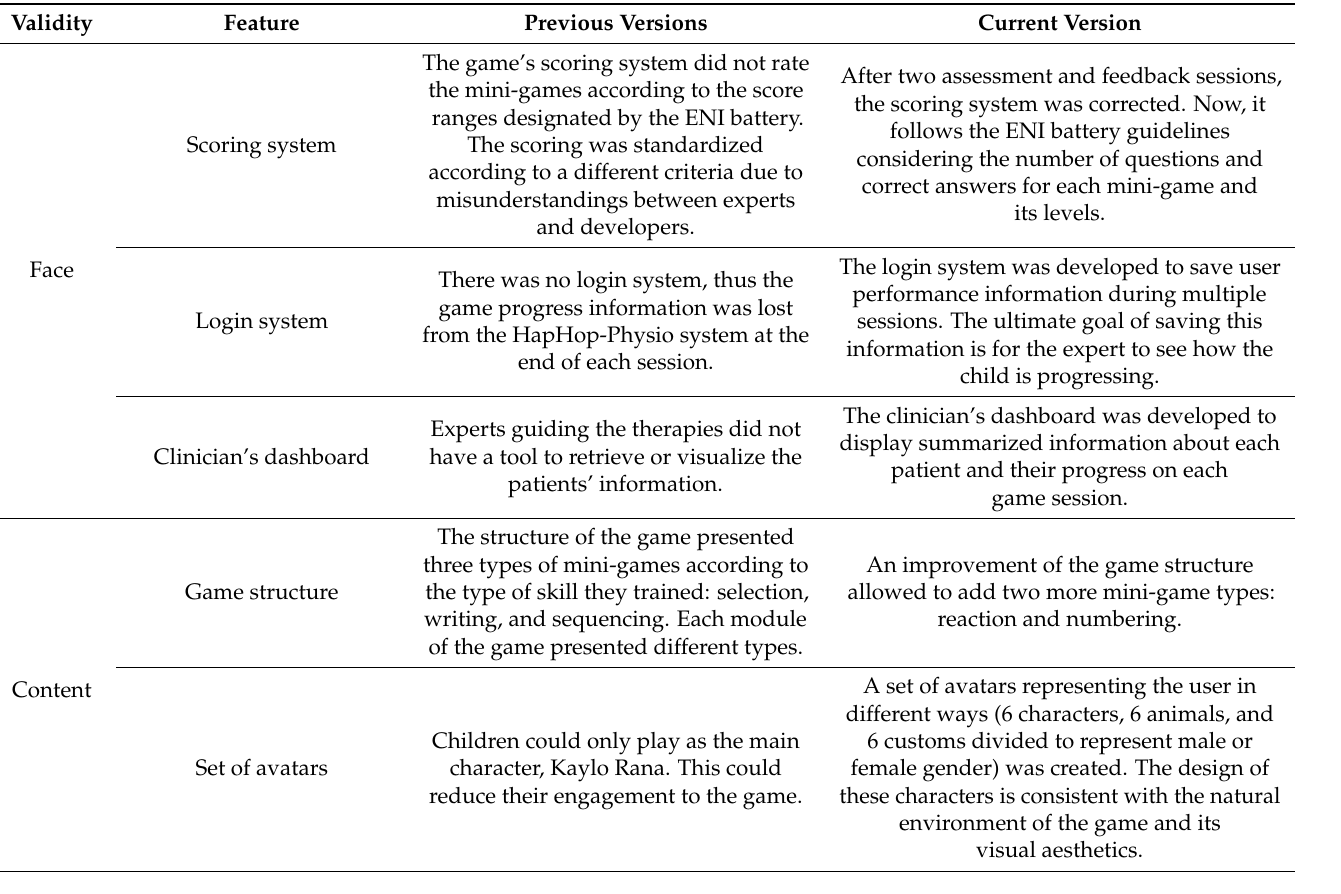
Table 3. Improved features of